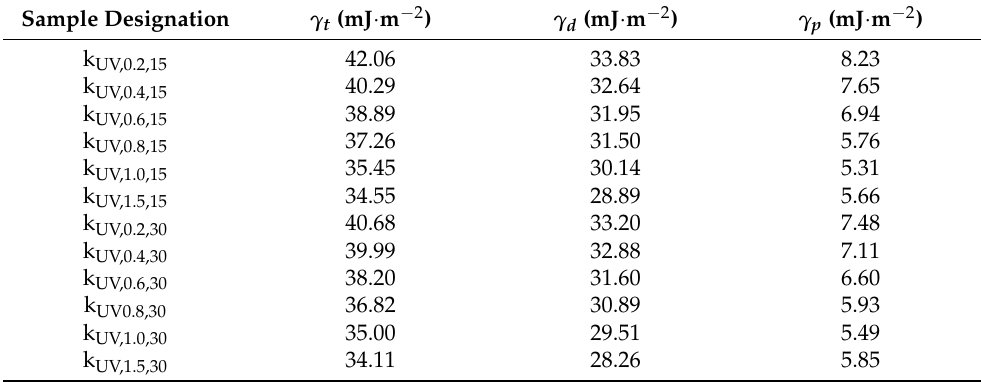
Table 6. Dispersive and polar components of the total surface energy using water and diiodomethane as probe